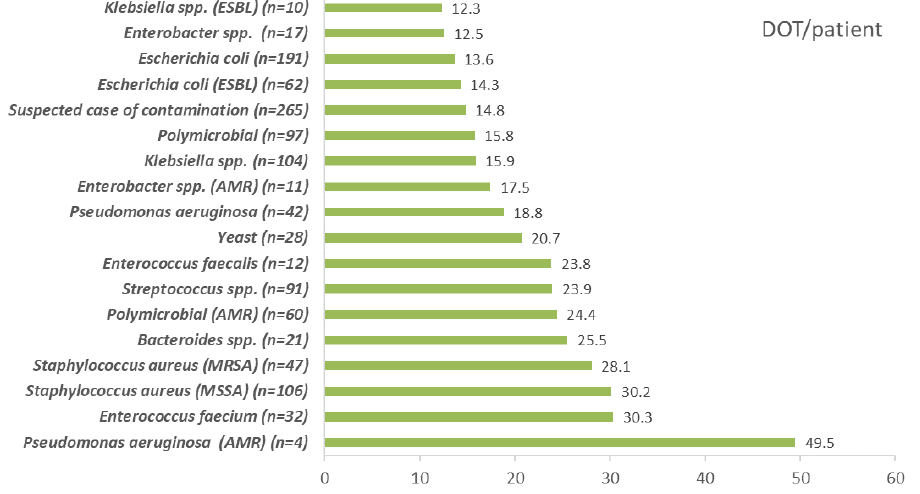
Figure 7. The DASC/DOT distribution stratified by BSI pathogens. DASC, days of antibiotic spec- trum coverage; DOT, days of therapy; MSSA, methicillin-susceptible Staphylococcus aureus ; MRSA, methicillin-resistant Staphylococcus aureus ; ESBL, extended-spectrum beta-lactamase; AMR, antimi- crobial resistance. 3. Discussion The present study revealed that the DASC metric could be applied to antimicrobial use evaluation in BSI patients. Previous reports on spectrum scoring have evaluated the de-escalation strategy because conventional antibiotic use metrics do not mirror the anti- biotic spectrum [20–24]. However, the antibiotic spectrum score application was limited to the frequently used antibiotics and infectious diseases. Moreover, the calculation pro- cess of scoring was complicated [21,22]. DASC was simply based on dichotomous scores for efficacy against microorganisms [18]. Therefore, the ASC scores list was exhaustive, as well as simple to set up. In this study, parallel changes in DASC and DOT per month were observed. A low DASC/DOT score would indicate that there was no broad-spectrum antibiotic overuse, although both DASC and DOT increased in September 2020. Conversely, no DASC and DOT increment in January 2021 with a DASC/DOT increment would be indicative of